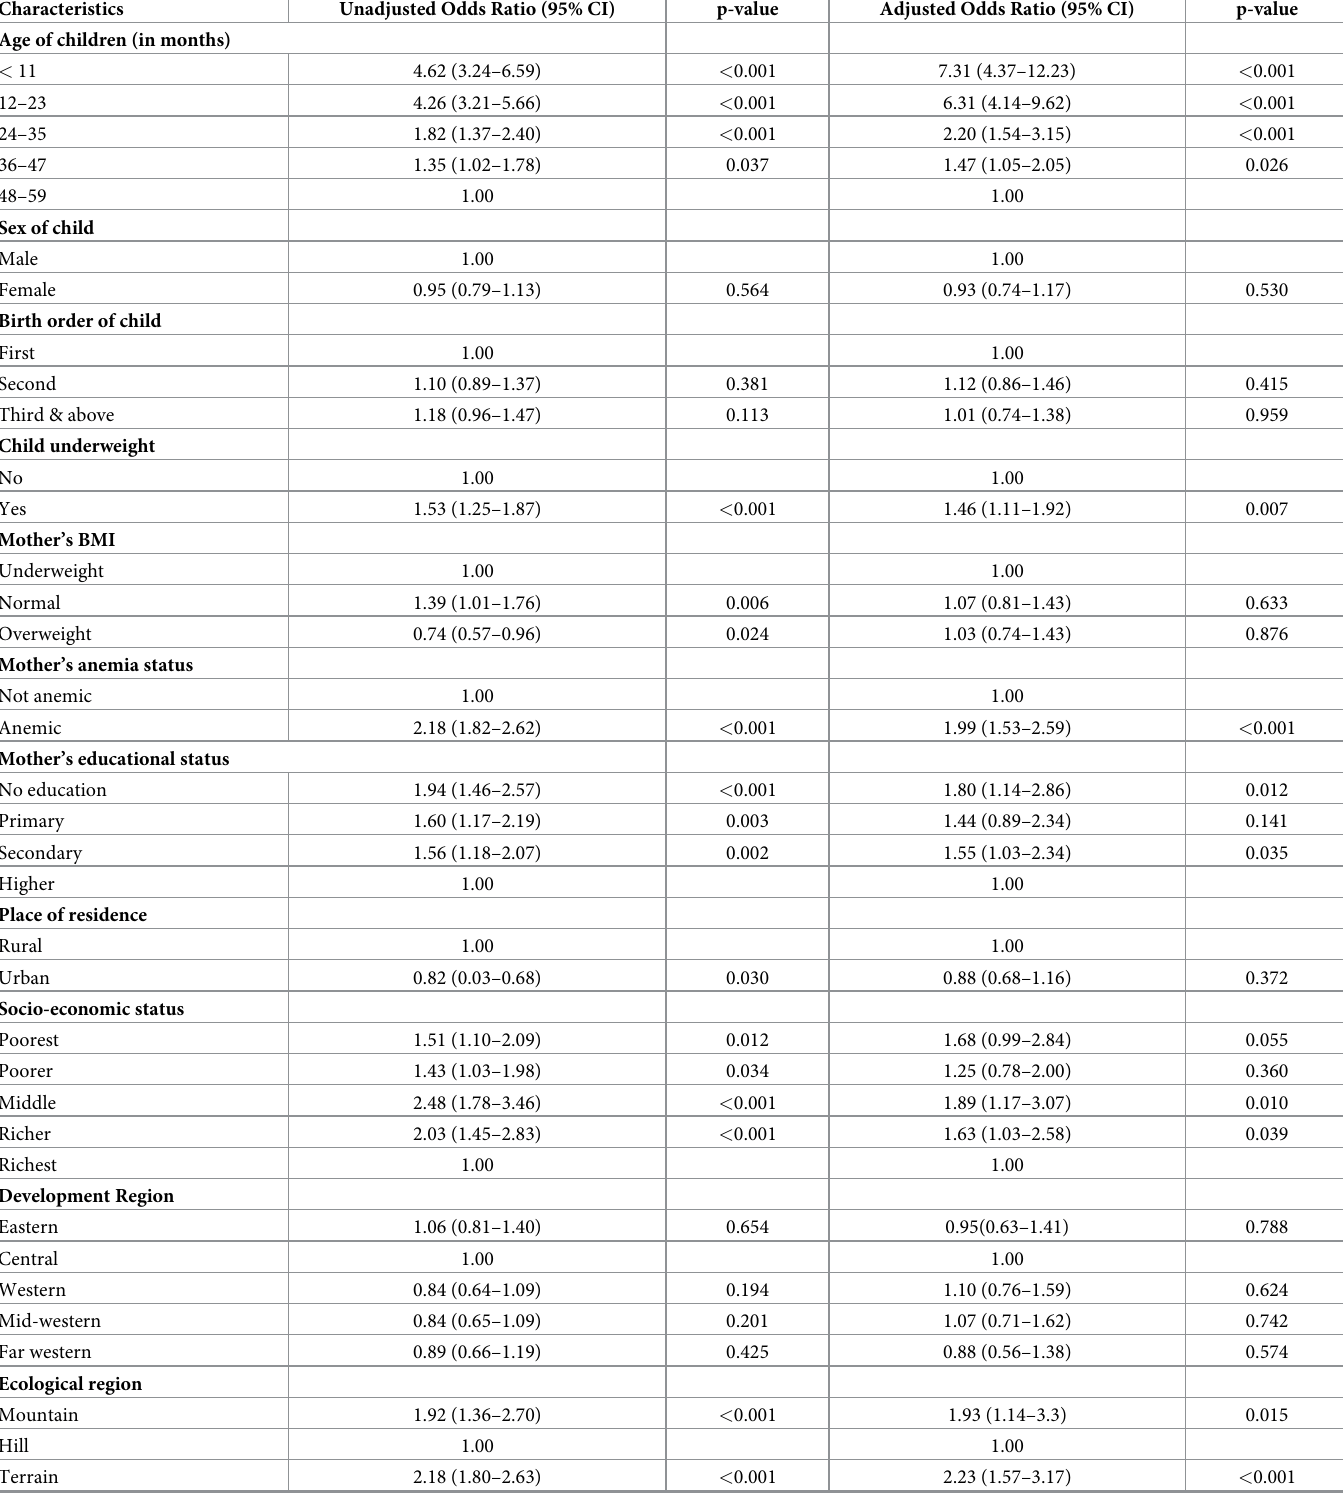
Table 2. Determinants of any level of anemia ( < 11.0 gm/dl) among children under 5 years old.